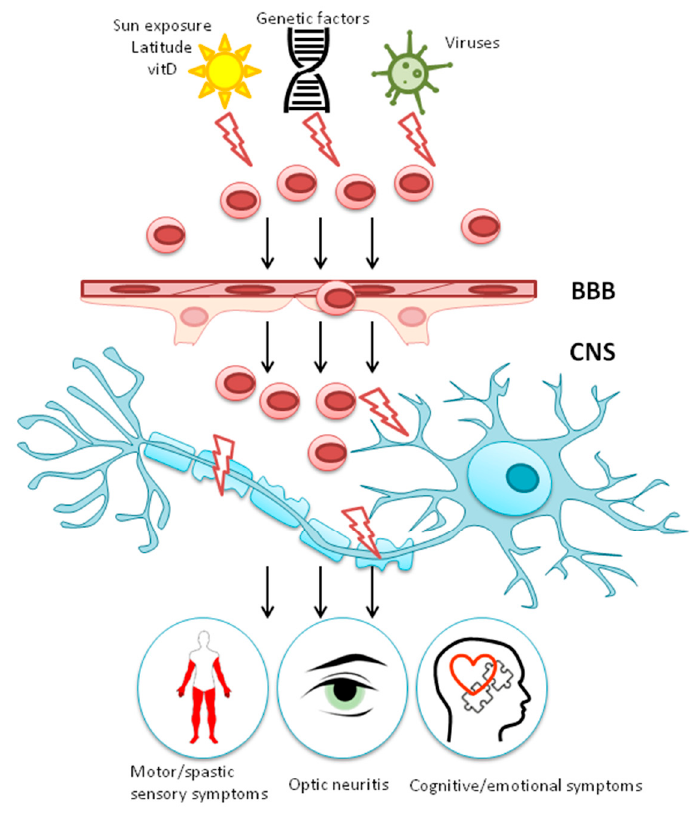
Figure 4. Pathogenesis of MS.